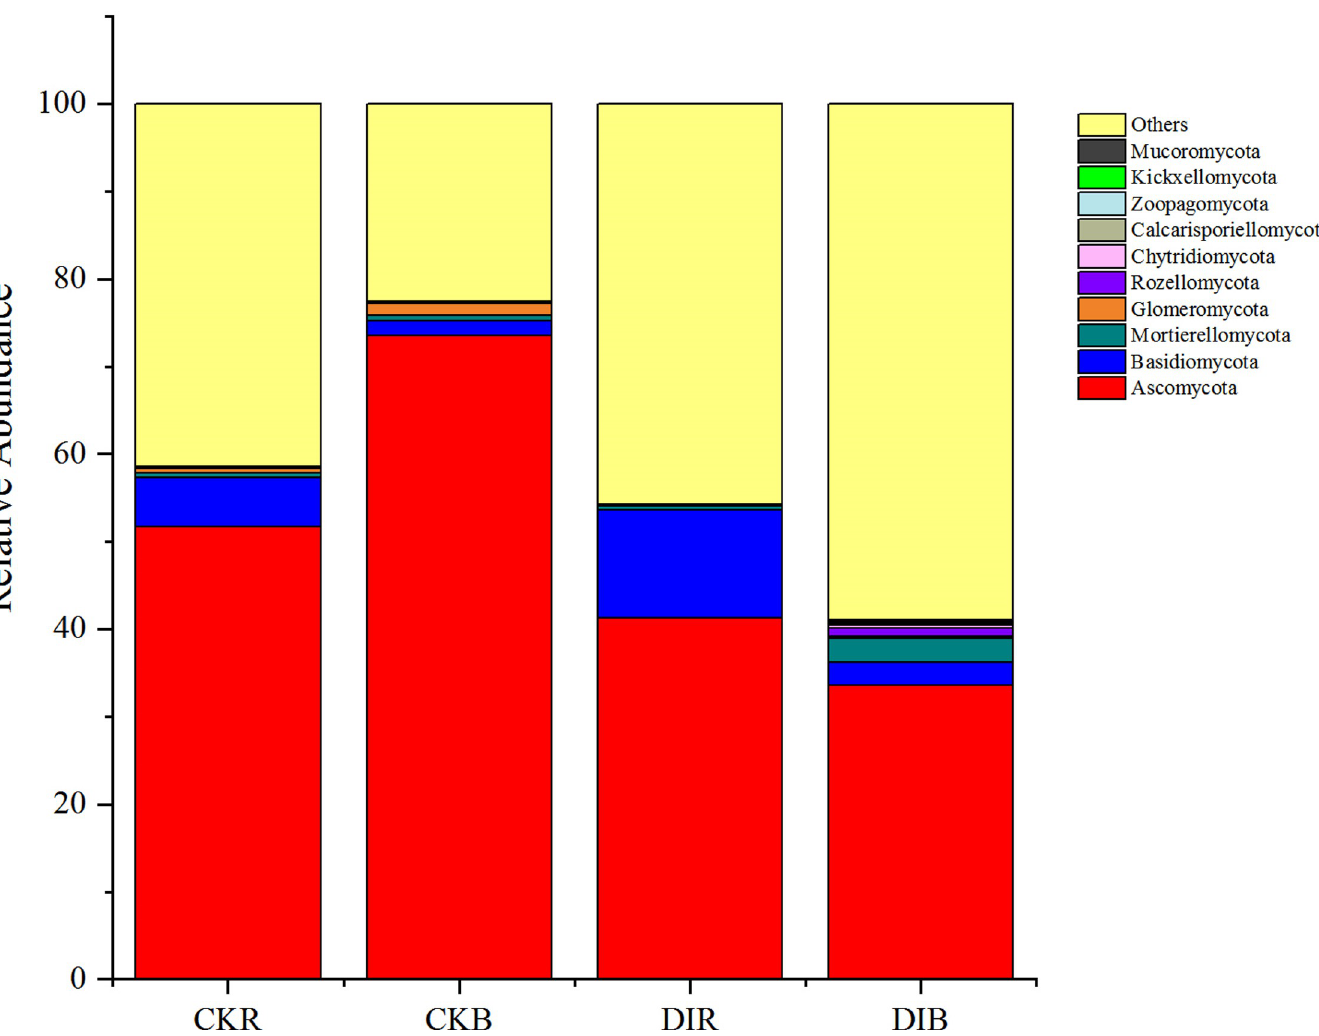
Fig 4. Distribution of fungal communities in response to different irrigation methods (phylum